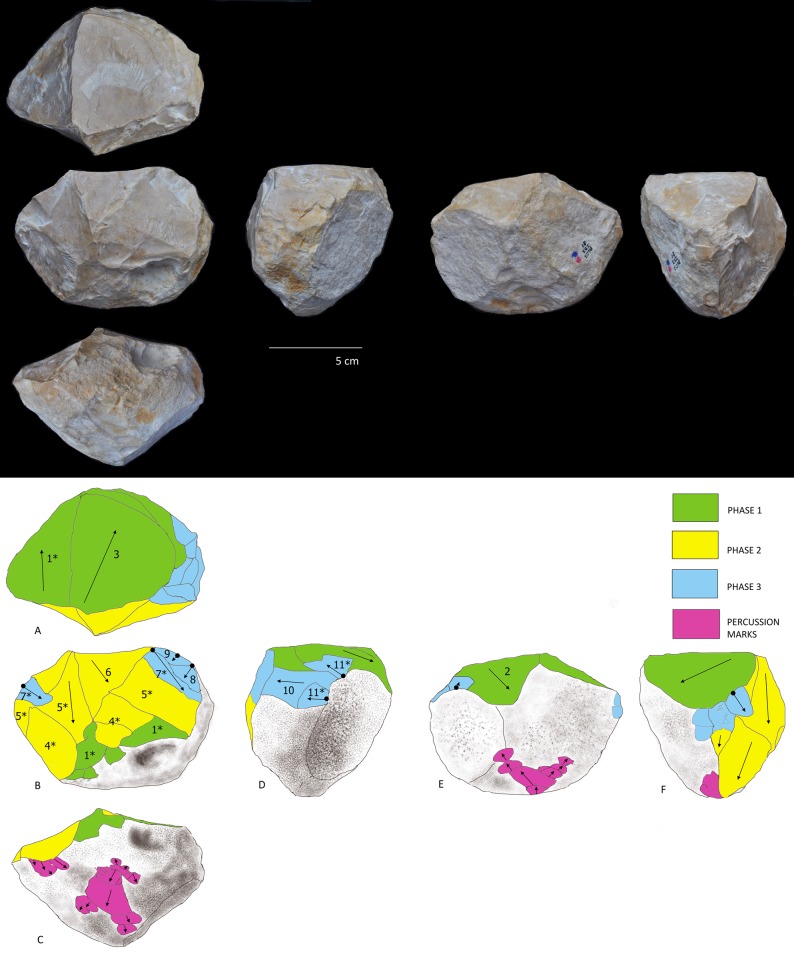
Photo and diacritical drawing of Tool G.Phase 1 (green): creation of the percussion platform (Profile A). Phase 2 (yellow): recurrent knapping series of flakes using orthogonal method from Phase 1 platform. Phase 3 (light blue): Tool rotation and small removals from cortical surface cutting previous negatives of Phases 1 and 2. A last phase (use) corresponds to accidental removals (purple), on convergent cortical surfaces and on Phase 2, due to percussion activity.